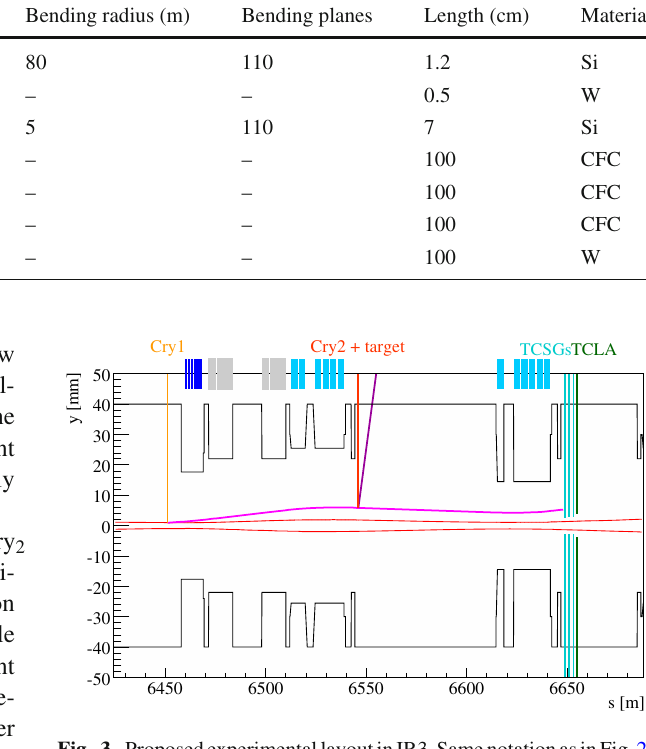
were to be used as primary collimator, it would intercept all particles diffusing out of the core so a second, symmet- ric apparatus would be useless. For retracted Cry 1